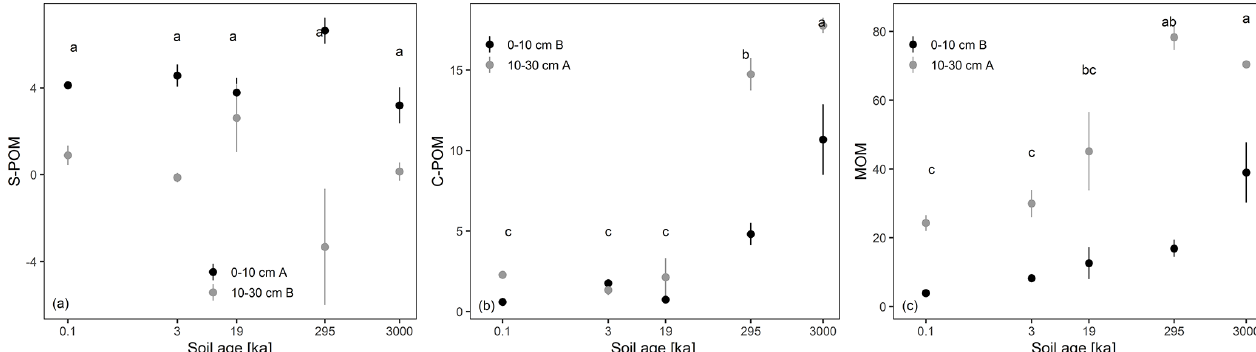
Figure 4. Mean ± standard deviation of site triplicates of the DRIFTS absorbance peak areas (unitless) corresponding to simple plant-derived OM (S-POM; a ), complex plant-derived OM (C-POM; b ), and mainly microbial-derived OM (MOM; c ) for 0–10 (black) and 10–30cm soil depth (grey). Homogeneous subgroups ( p< 0 . 05) across soil age are indicated with letters. Significant differences between soil depth are indicated with letters behind the depth classes in the legend. The subgroups were identified by pairwise comparison (Tukey’s HSD) following a two-way ANOVA ( n = 30). Soil age is spaced based on the log-transformed age differences.